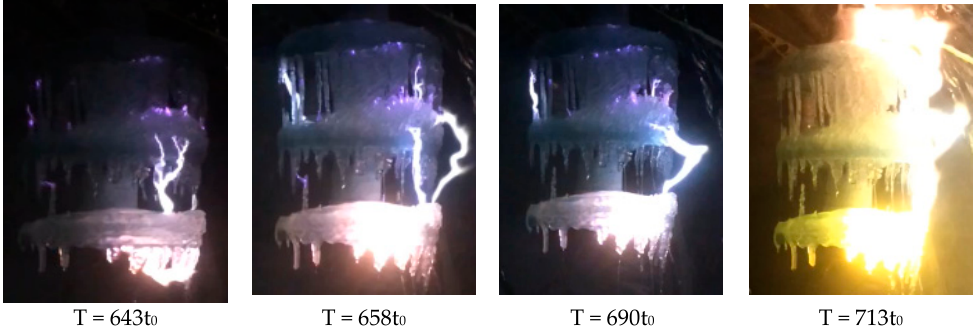
Figure 10. Flashover process of insulator string with applied AC voltage (t 0 = 0.02 s).